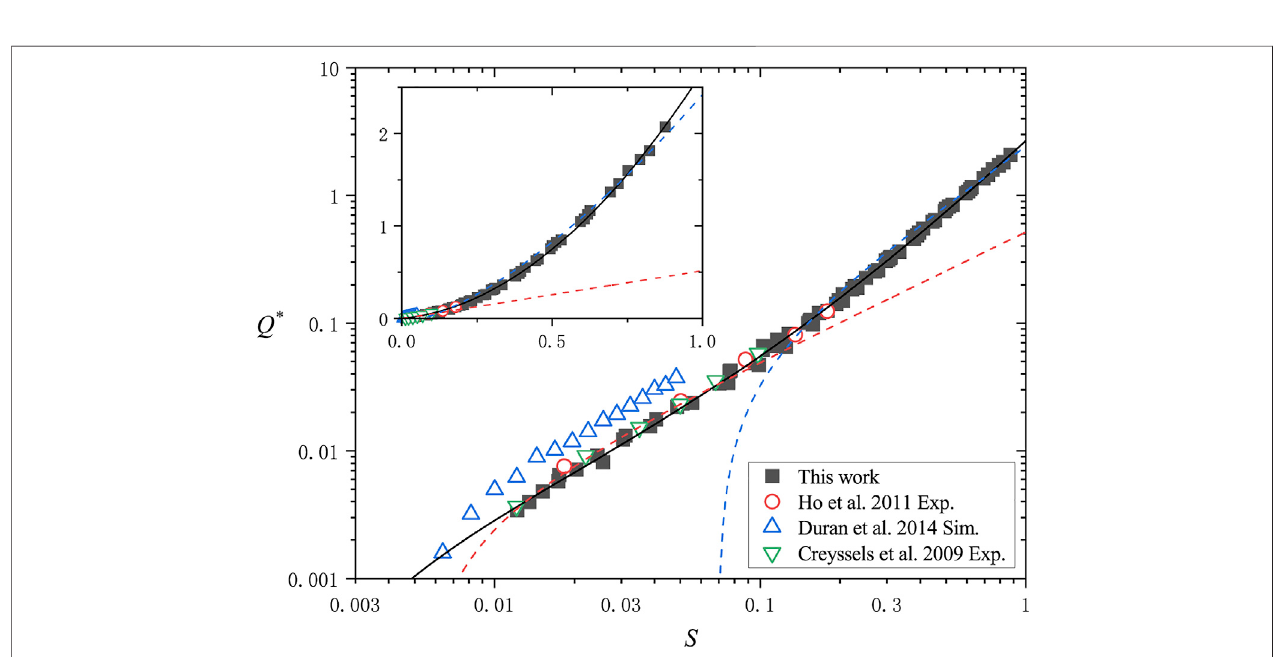
FIGURE 4 | Development of nondimensional particle transport fl ux versus the Shields number. Inset demonstrates the same value in the linear coordinate system. The red dashed line is the linear fi tting line for data points with S < 0 . 1. The blue dashed line is the cubic fi tting line. The black soiled line is the fi tting line of (31) . Hollow symbols represent data from others ’